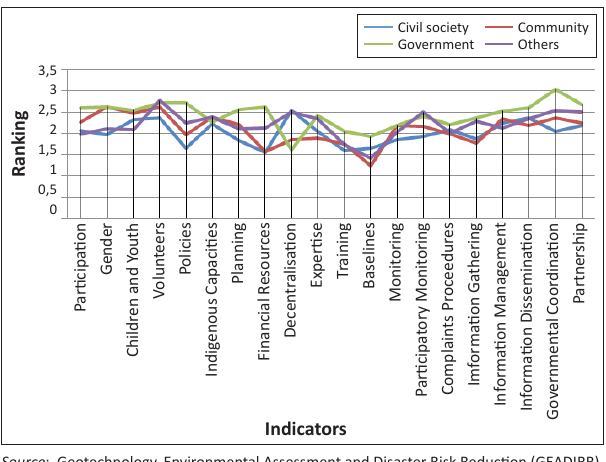
FIGURE 2 : Ranking of Cameroon local governance indicators on DRR